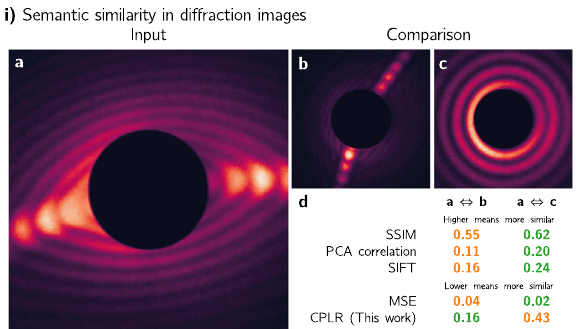
Fig. 1 Illustrating semantic similarity. a – c are diffraction images taken from a publicly available dataset 37 from an SP-CDI experiment on super fl uid helium nanodroplets 12,22 . a , b are semantically similar while a and c are not. d shows four widely used similarity measures — the structural similarity index (SSIM) 39 , the correlation of the principal components, the mean-squared-error (MSE), and the keypoint-based scale-invariant feature transform (SIFT) distance 40 — that disagree with the human perception, while only our method (labelled CPLR) agrees with it. Color-coding is that the pair of images that is more-similar is green, while the one that is less-similar is